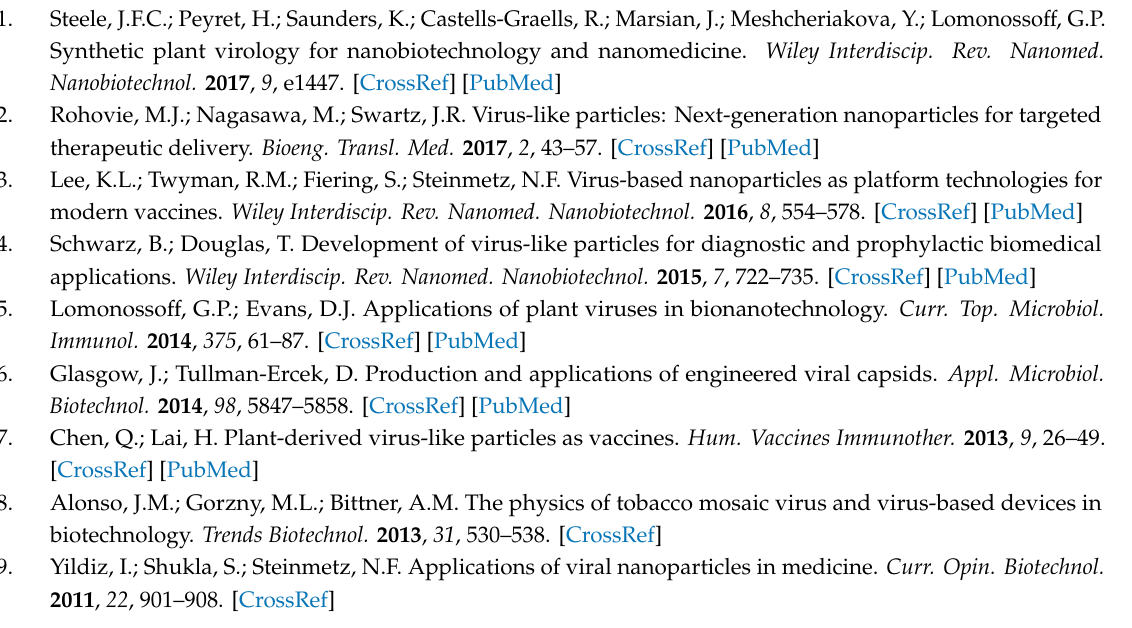
Figure S1. Vector p35Tunos-Vec01-NAT1. Figure S2. Vector pENTR / D-TOPO. Figure S3. Vector pEAQ-HT-Dest1. Figure S4. Sensitivity comparison between di ff erent detection platforms using commercial antibodies. Figure S5. Autoantibody levels in sera measured with Hsp60-VLPs (blue) and Hsp60 protein